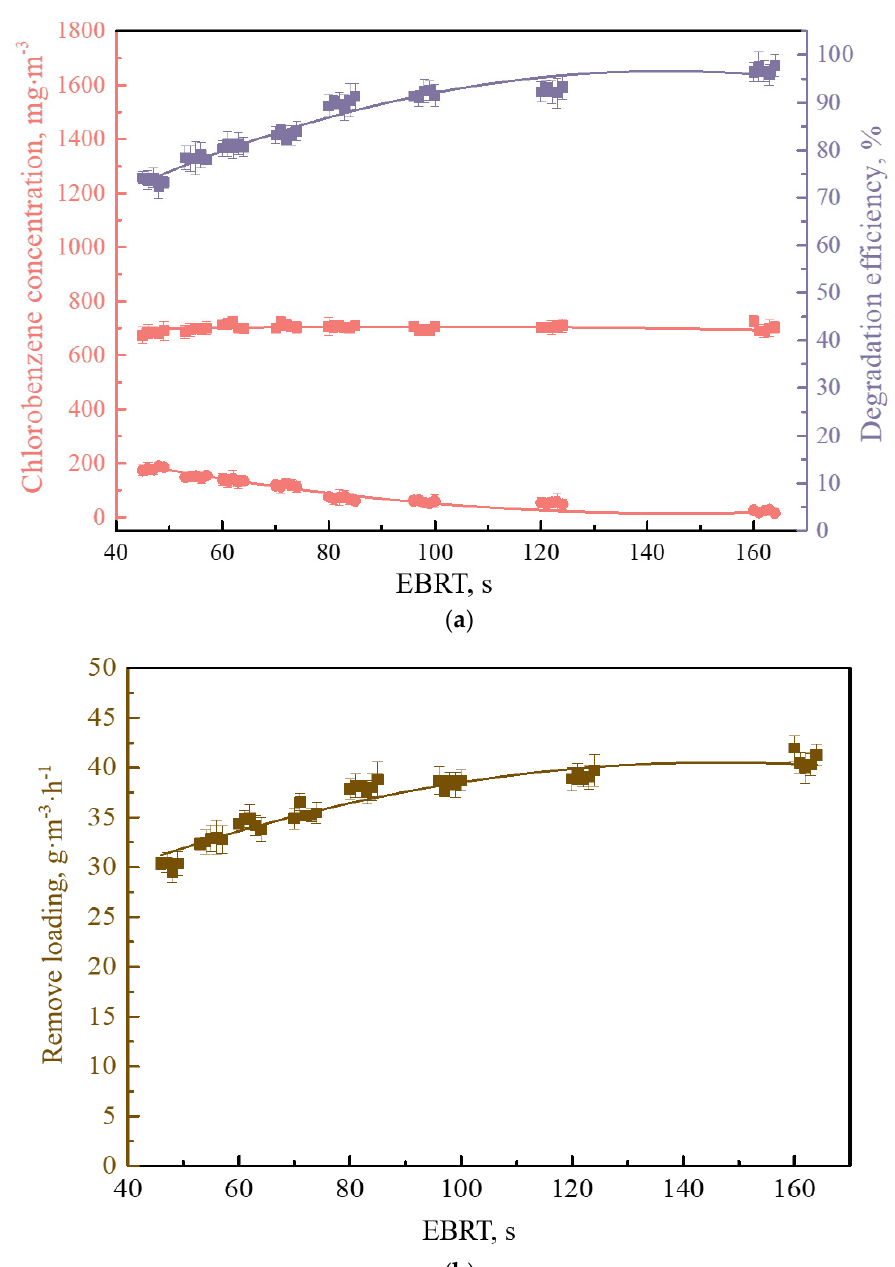
Figure 5. ( a ) The degradation efficiency of chlorobenzene under different EBRTs. ( b ) The removal loading of chlorobenzene under different EBRTs. Inlet concentration of chlorobenzene = 700 mg·m − 3 , liquid rate = 5.17 m 3 ·m − 2 ·h − 1 , pH = 6.5–7.0, oxygen concentration = 10%. ■ Degradation efficiency ■ Inlet concentration ● Export concentration.